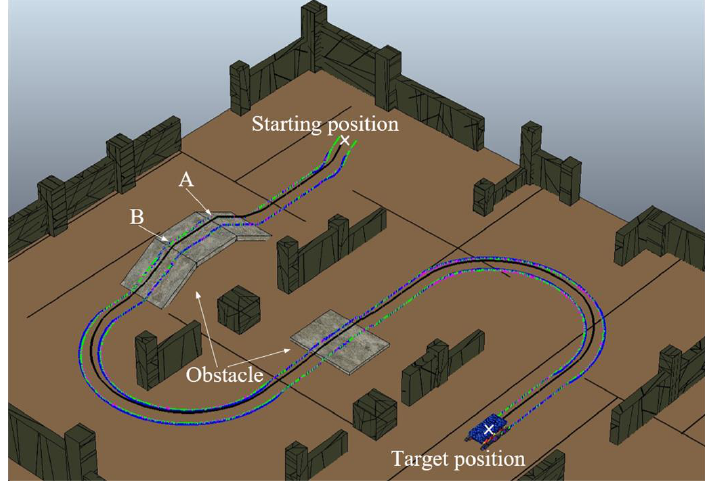
Figure 6. S-curve scenario experiment with slopes and short step obstacles. Point A indicates that the robot is in a raised pose at the climbing end stage. Point B indicates that the rapid drop of the robot under the effect of gravity after the robot passes through the flat slope.